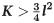
The manufacturer's profit with α in K>34l2.